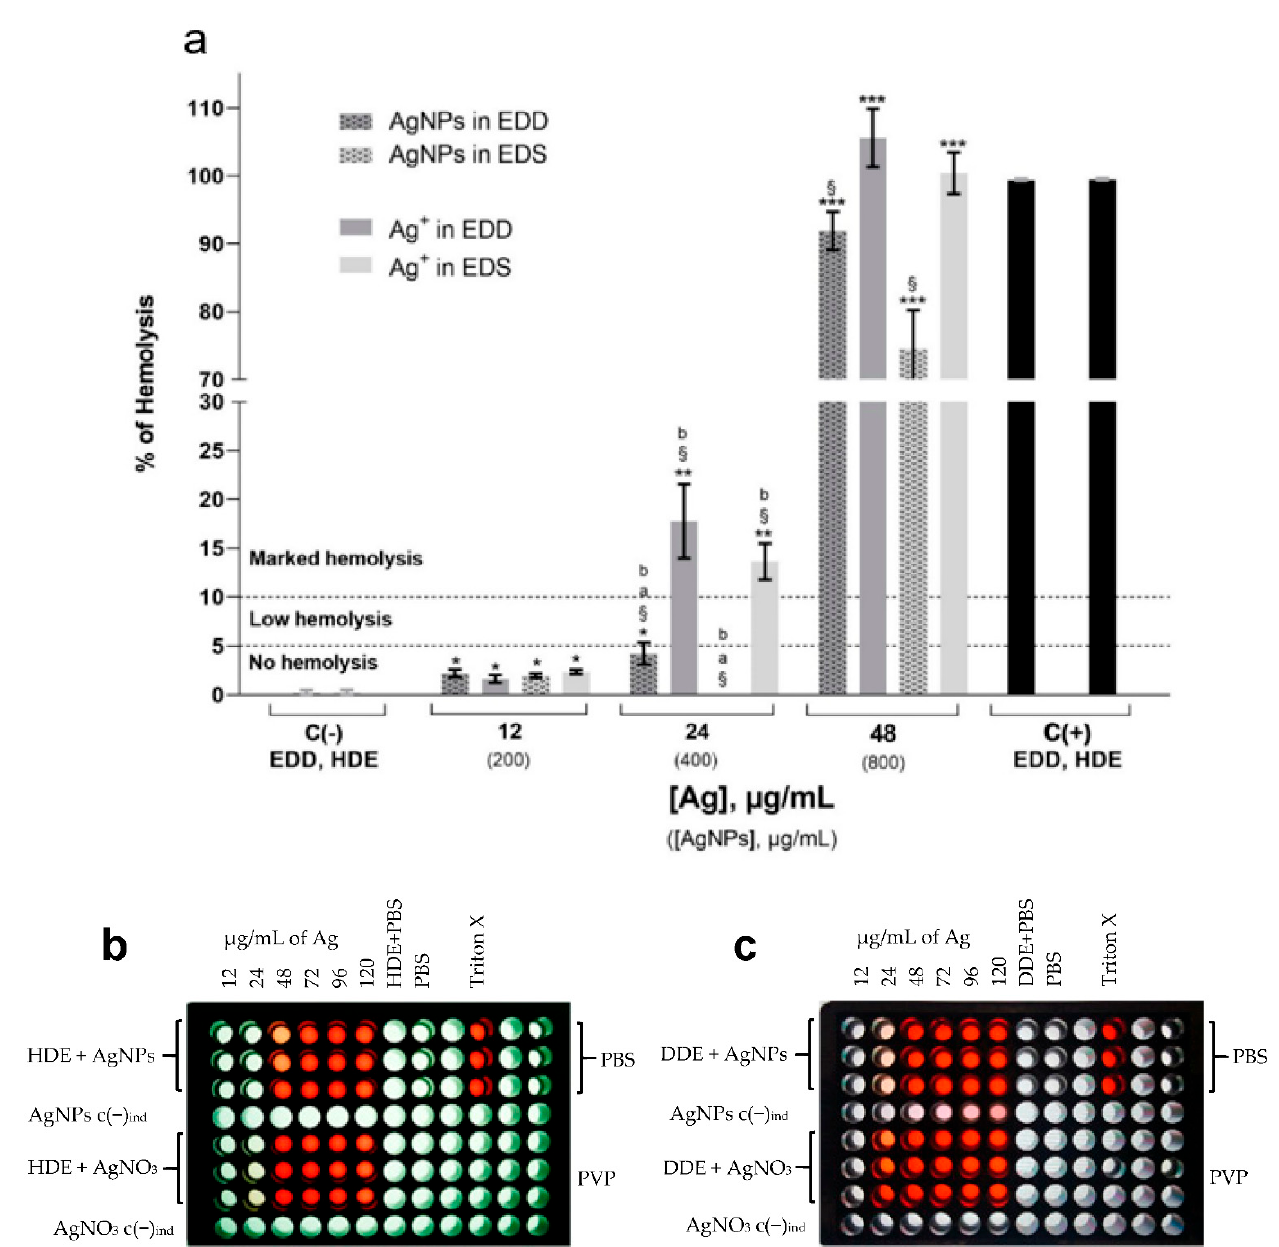
Figure 2. ( a ) Hemolysis in diabetic donor erythrocytes (DDE) and healthy donor erythrocytes (HDE) induced by AgNPs and Ag + , PBS negative controls C( − ) and Triton X-100 C(+). Dotted horizontal lines separate the limits of no hemolysis (<5%), low hemolysis (5-10%), and marked hemolysis (>10%). The average of PBS negative controls C( − ) and Triton X-100 positive controls C(+) are presented. The standard error of the mean (SEM) is shown in each bar. p -value is indicated on the top of each bar, * ( p ≤ 0.05), ** ( p ≤ 0.01), and *** ( p ≤ 0.001) compared with the negative control. § p ≤ 0.01 compared to positive control. a p ≤ 0.01 comparing DDE vs. HDE, b significant difference comparing AgNPs vs. Ag + in AgNO 3 . Values in parenthesis indicate complete formulation concentrations; 96-well plate layouts and supernatant appearance of ( b ) HDE and ( c ) DDE exposed to AgNPs and AgNO 3 at various concentrations of Ag content. The concentration of 48 µg/mL from either AgNPs or Ag + produce marked hemolysis, similar to the positive control Triton. Even with marked hemolysis, lower damage by AgNPs is done compared with Ag + . AgNPs at 48 µg/mL produce 74.6 ± 5.6% (*** p ≤ 0.001) hemolysis, meanwhile Ag + produces 100.3 ± 3.0% (*** p ≤ 0.001) on the HDE, a difference that represents 25% of susceptibility for Ag + . On the DDE, the difference is close,